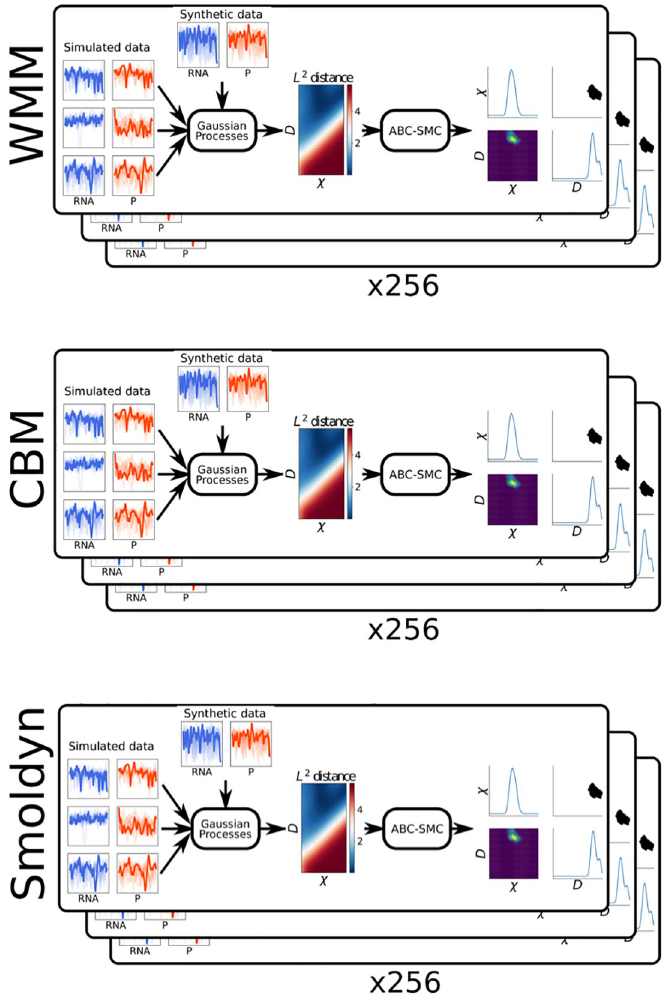
Fig 3. Illustration of the computational experiments performed. For the different data-scenarios and for each combination of distance metric and amount of data, we execute the pipeline using all 256 synthetic data sets as observed data, and for each of the three